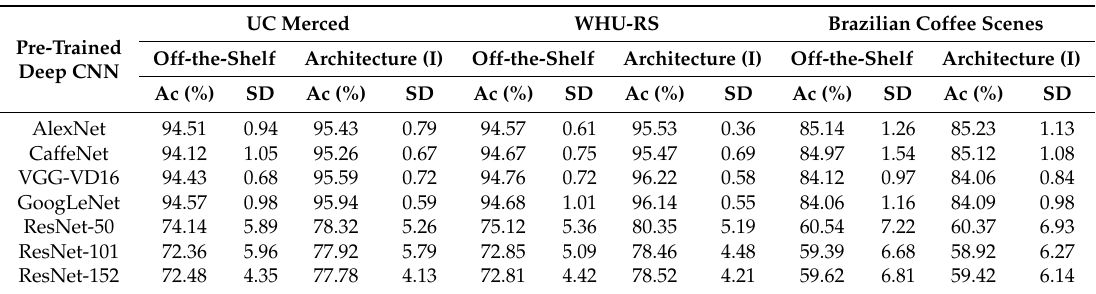
Table 1. Remote scene classification results of five well-known pre-trained deep CNNs on three different remote sensing